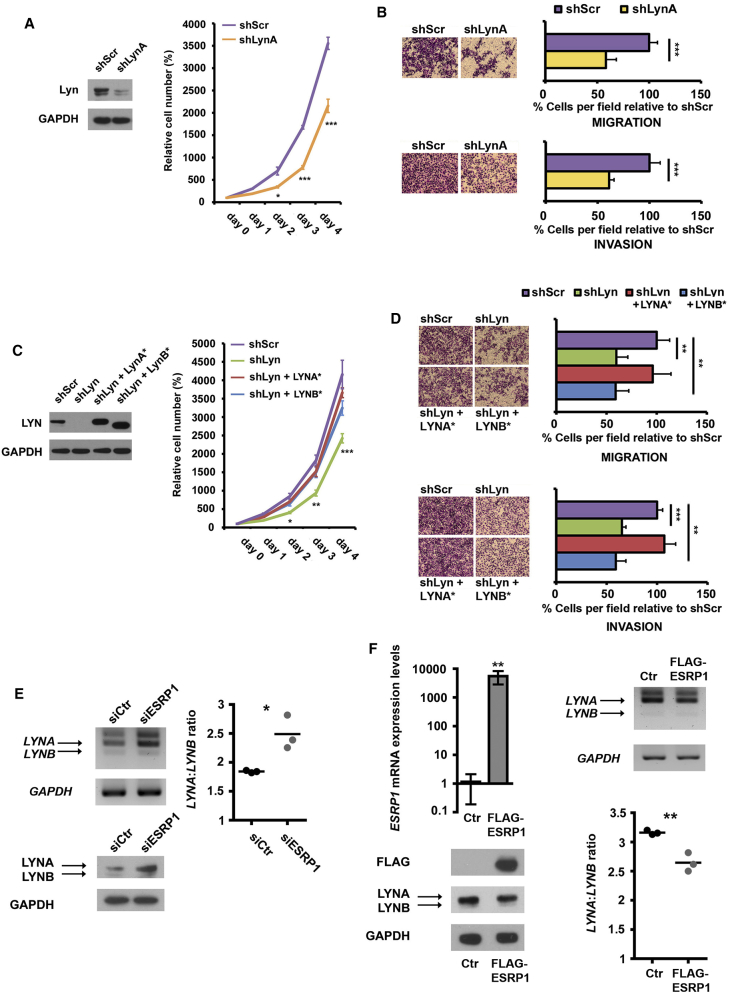
LYNA Drives Migration and Invasion in Breast Cancer Cells(A) Western blot of LYN protein levels and growth of control (shScr) and LYNA knockdown (shLynA) MDA-MB-231 cells relative to shScr cells at day 0.(B) Migration and invasion of shScr- and shLynA-MDA-MB-231 cells, assessed by transwell assay. Representative images show endpoint assays, and quantification of results compares the percentages of cells per field to shScr cells.(C) Total LYN knockdown and LYNA or LYNB reconstitution using shLyn-resistant forms (LYNA/B∗) in MDA-MB-231 cells. Western blot shows LYN knockdown cells forced to express either LYNA or LYNB and growth relative to shScr cells at day 0.(D) Migration and invasion of control MDA-MB-231 (shScr) cells, LYN-depleted (shLyn) cells, cells expressing LYNA only (shLyn + LYNA∗), or cells expressing LYNB only (shLyn + LYNB∗). Representative images show endpoint assays, and quantification of results compares the percentages of cells per field to shScr cells.(E) siControl (siCtr) and siESRP1 MCF7 cells were analyzed for LYNA::LYNB transcript ratio and LYN protein levels by semiquantitative RT-PCR (top, with quantitation) and western blot (bottom), respectively.(F) MDA-MB-231 cells were transduced with control (Ctr) or FLAG-tagged ESRP1 (FLAG-ESRP1) lentiviruses. ESRP1 overexpression was assessed by qRT-PCR (fold expression over comparator Ctr cells; upper left panel). Ctr and FLAG-ESRP1 cells were analyzed for LYNA:LYNB transcript ratio by semiquantitative RT-PCR (bottom panels), and LYN and ESRP1 protein levels were analyzed by western blot (upper right panel).Blots are representative of three independent experiments. Quantitation is shown as mean and SD (n = 3; two-tailed unpaired t tests), except for gene expression analysis by quantitative real-time RT-PCR (mean ± 95% confidence intervals; significance of real-time RT-PCR data was determined from confidence intervals; n = 3 independent experiments for each of 3 technical replicates per sample) (Cumming et al., 2007). ∗p < 0.05; ∗∗p < 0.01; ∗∗∗p < 0.001. See also Figures S7 and S8.